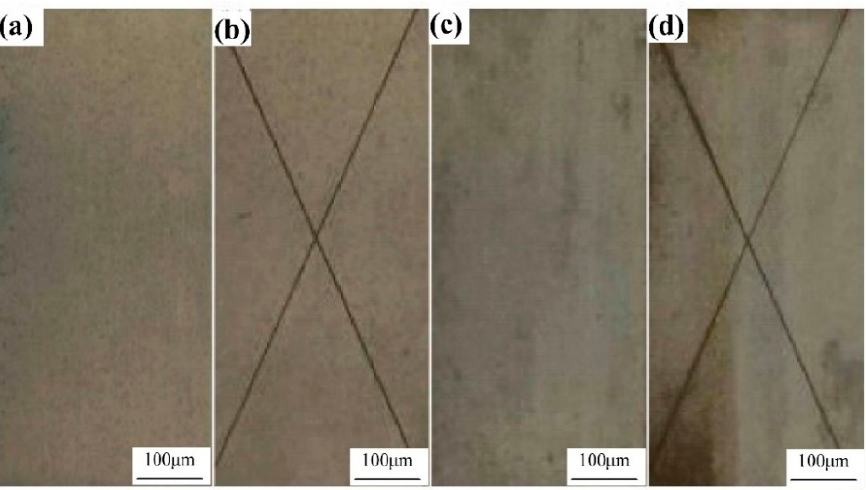
Figure 12. Al 0.7 FeCoCrNiCu 1.00 coating specimens exposed to atmosphere for 12 months ( a , b ) Beijing; ( c , d ) Tuandao.